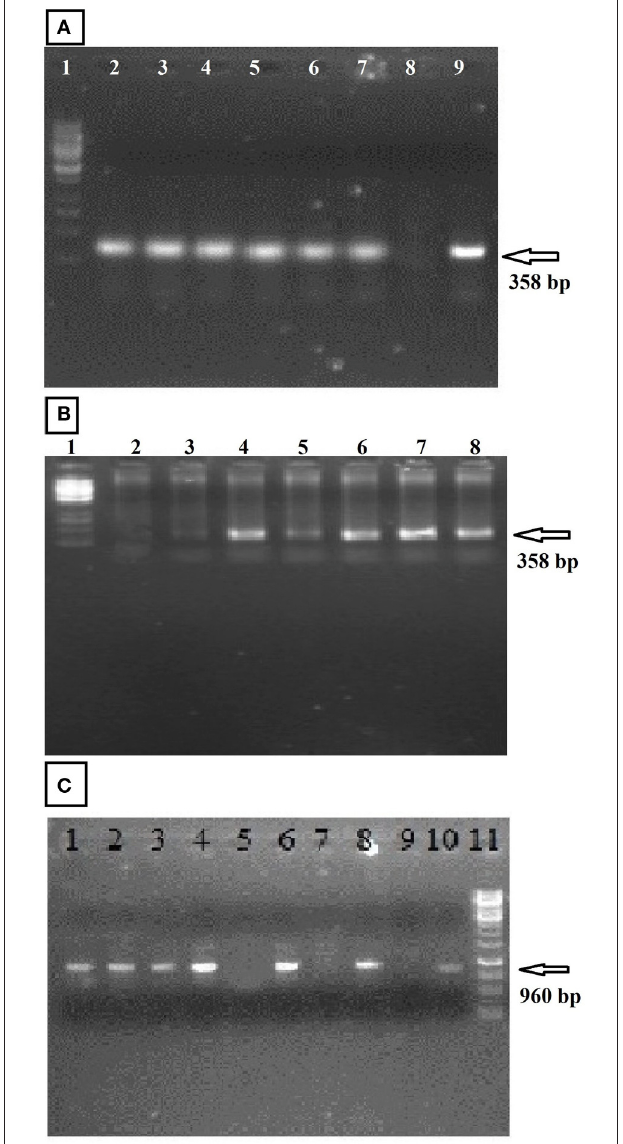
FIGURE 2 | PCR amplification of transgenic cotton plants during three generations (Fiber Gene GhEXPA8 ). (A) represented the PCR amplification of transgenic cotton plants at T 0 generation, lane 1: 1kb DNA marker, lane 2–7: transgenic cotton plants, Lane 8: Negative Control, Lane 9: Positive Control; (B) PCR amplification of transgenic cotton plants during T 1 generation, lane 1: 1kb DNA marker, lane 2: negative control, lane 3–8: transgenic cotton plants; (C) During T 2 generation Lane 1–8 show putative transgenic plants in which lane 1, 2, 3, 4, 6, and 8 show positive transgenic plants having gene amplification from orientation primers resulting in band of 960bp whereas, Lane 5 and 7: untransformed cotton (negative amplification), Lane 9: DNA from untransformed cotton (Negative Control), Lane 10: DNA from pGA482- GhEXPA8 (Positive Control), lane 11:1kb DNA ladder Whereas, the arrow indicate the detection of gene in transgenic cotton plants.